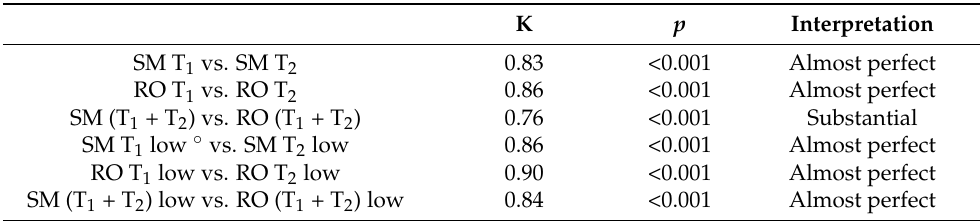
Table 1. Cohen weighted κ coefficient for intraobserver and interobserver agreement at two time intervals (T1 and T2).